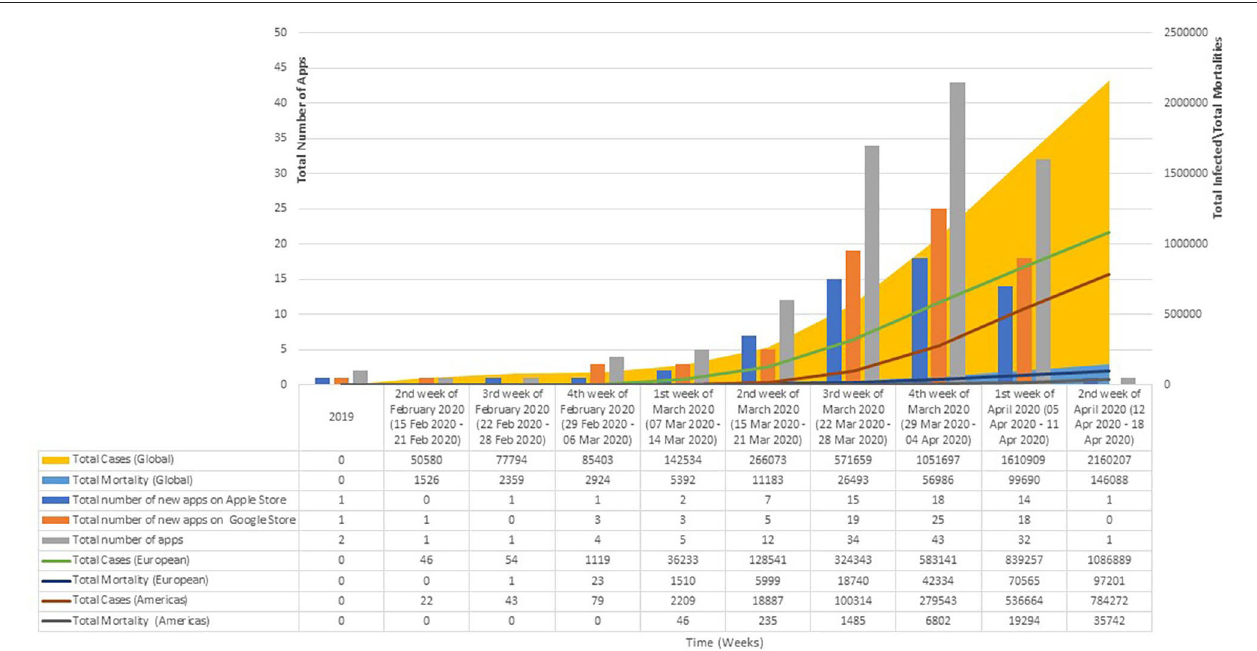
FIGURE 2 | Availability of commercial apps by total numbers of infected/mortalities. Sunday is taken as the 1st day of the week for the computation of the number of new applications that are available on the stores. The numbers of individuals infected, and the total moralities figures have been extracted from the World Health Organization’s COVID-19 Situation Reports. There were no available figures for 2019 as the first WHO Situation Report was published on 21 Jan 2020. The line graphs present the overall total number of infections and mortalities in Europe and the United States.